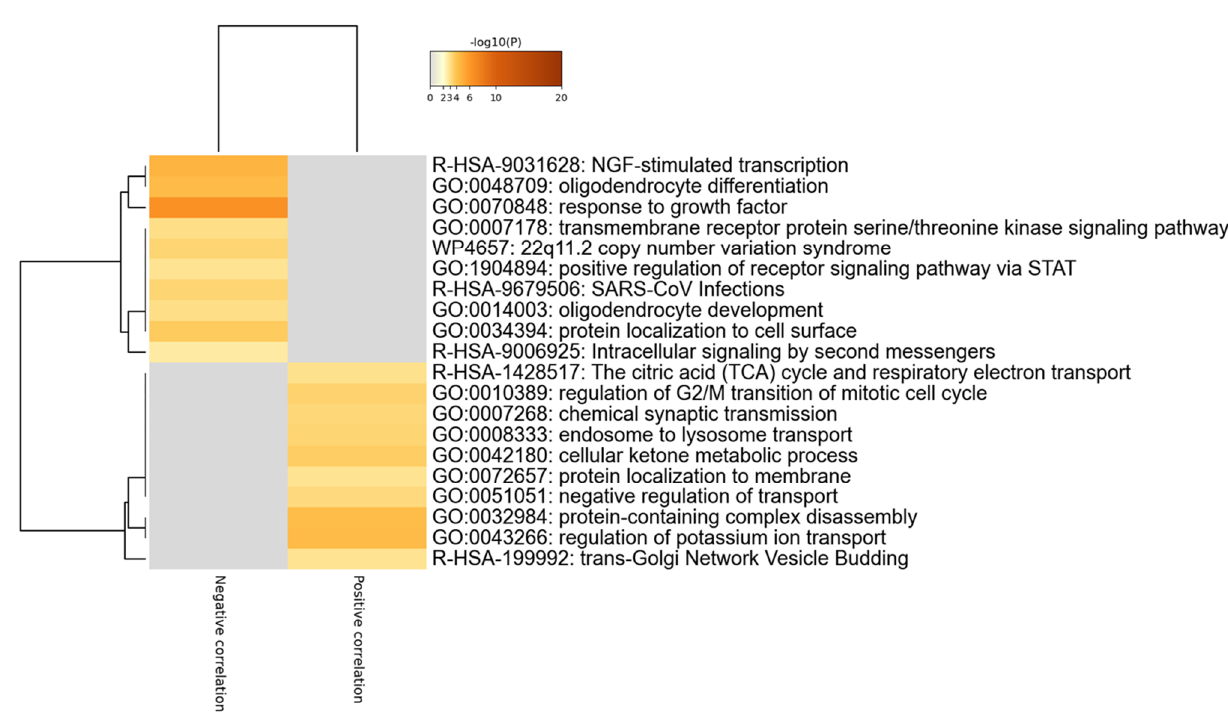
Figure 4. Gene Ontology and pathway analysis for the genes most correlating with LSGALS8 in SCZ hippocampus. Genes significantly correlated to LSGALS8 in SCZ hippocampus were identified by calculating the Pearson correlation, and the statistical significance was computed using a permutation test, with 1000 random permutations. The graph represents the hierarchical clustering of the most enriched biological processes and gene ontologies among the genes significantly correlated to LGALS8 , as determined using the web-based utility, Metascape.